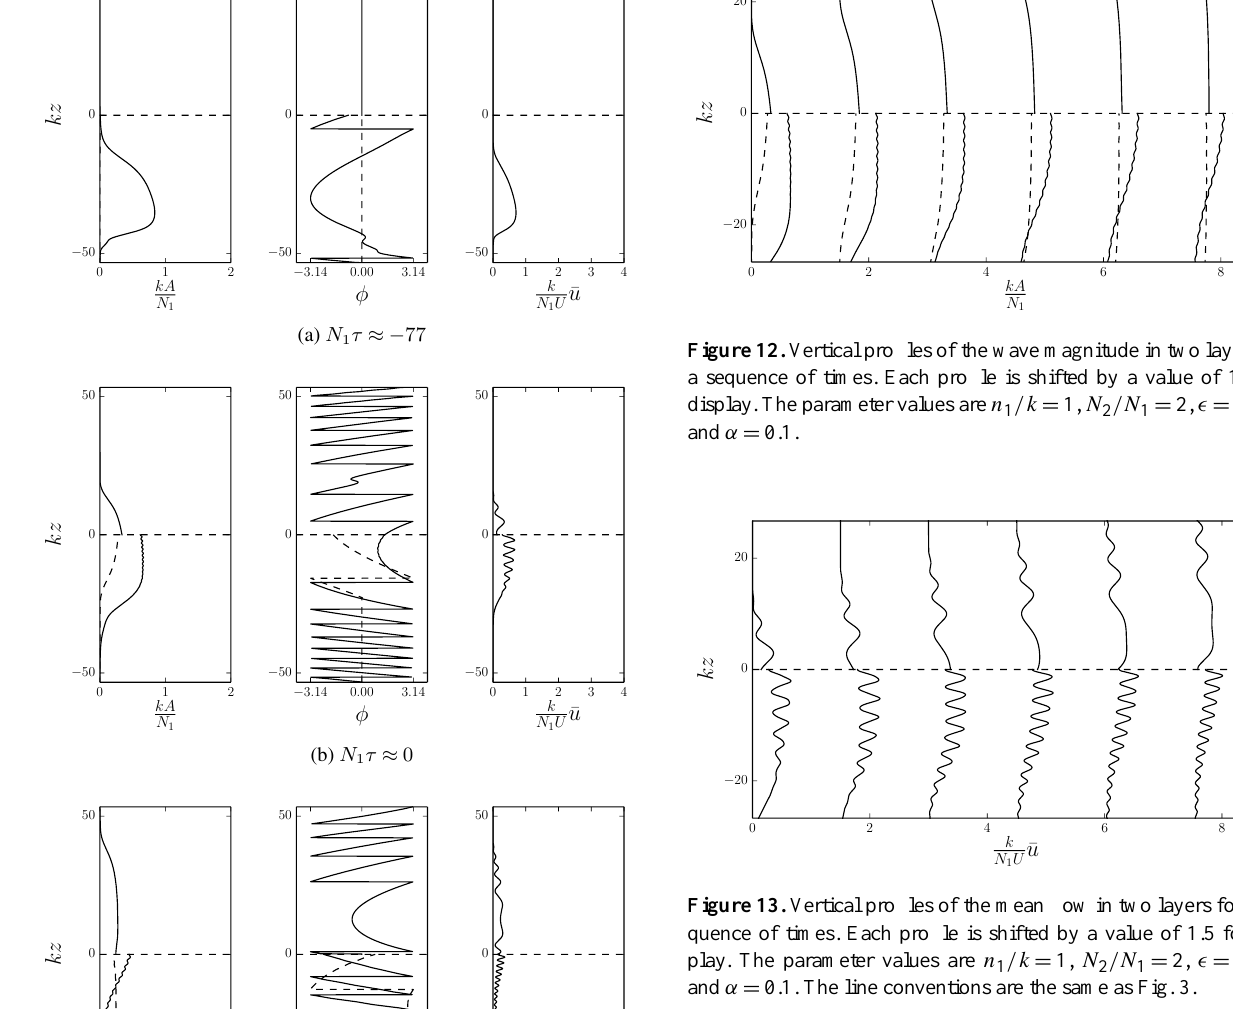
on z = 0, resulting in